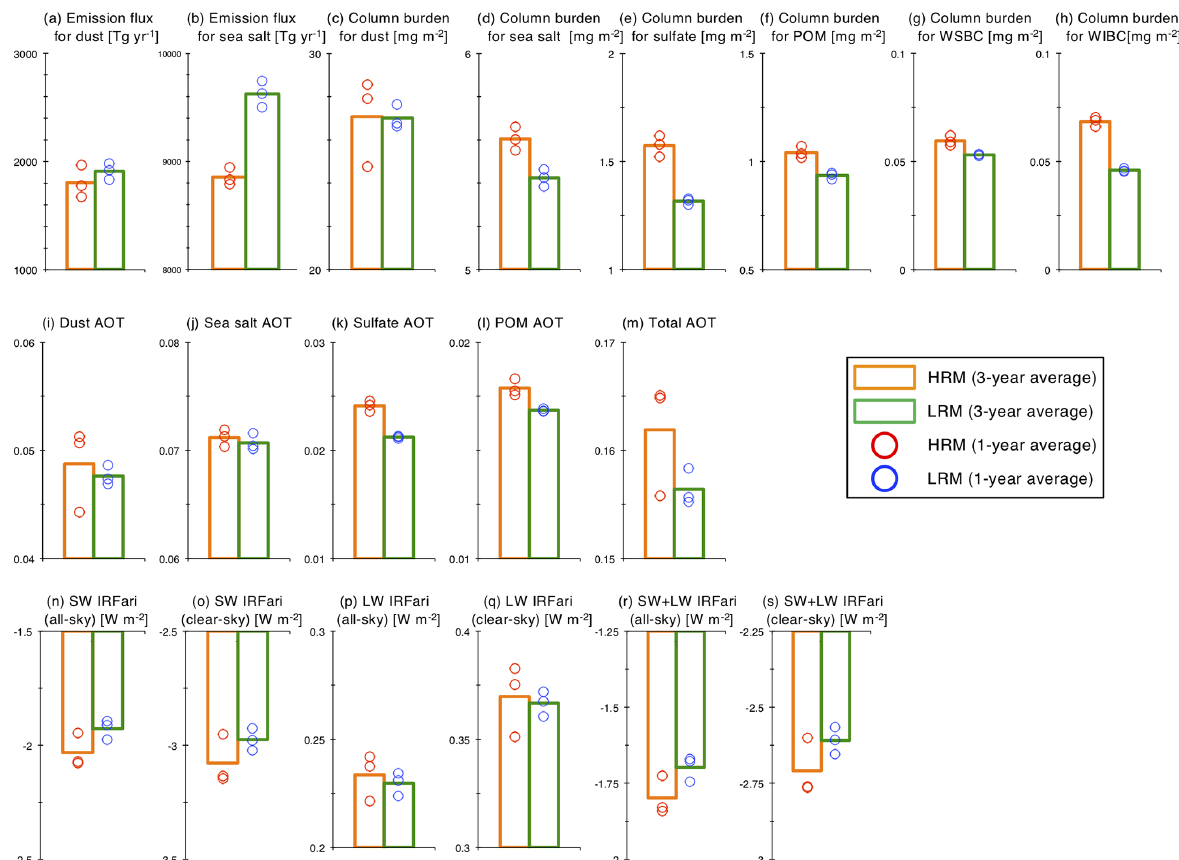
Figure 16. Global annual averages of the emission fluxes (for dust and sea salt), column burdens (for dust, sea salt, sulfate, OC, WSBC and WIBC), AOTs (for dust, sea salt, sulfate, carbon and total amount) and direct ARF (IRFari) at the TOA (shortwave (SW), longwave (LW) and total (SW and LW) under all-sky and clear-sky conditions) by the 3-year averages as well as each 1-year average in both the HRM and